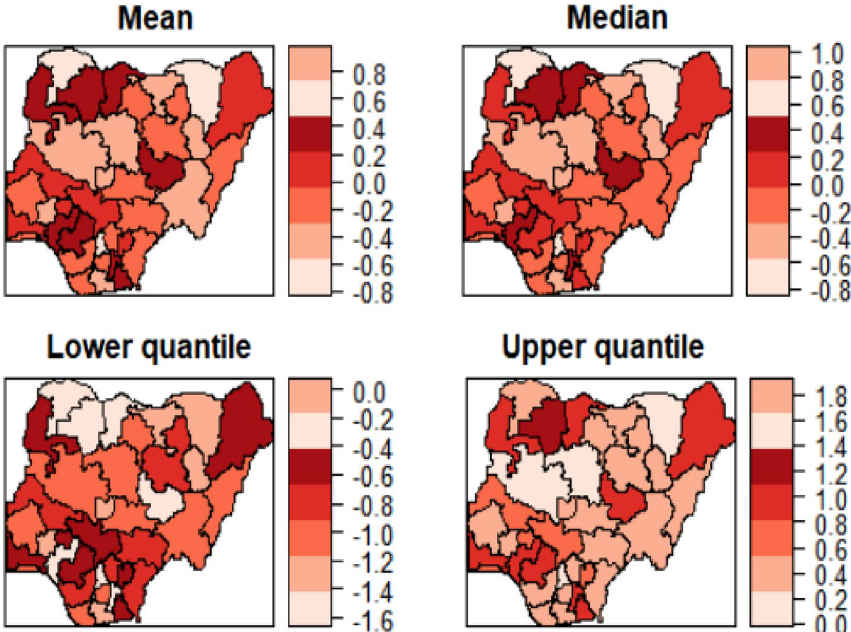
Figure 4. Nigeria state-level e stimated posterior mean of the unstructured spatial effect maps: (a) Mean, (b) Median, (c) 25% quantile and 97.5% quantile for